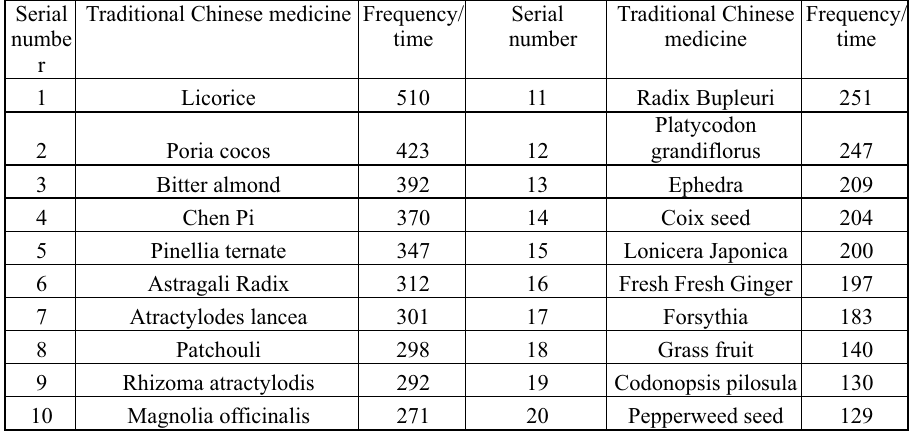
Table 1. Frequency distribution of core drugs of traditional Chinese medicine in covid-19 prescription.